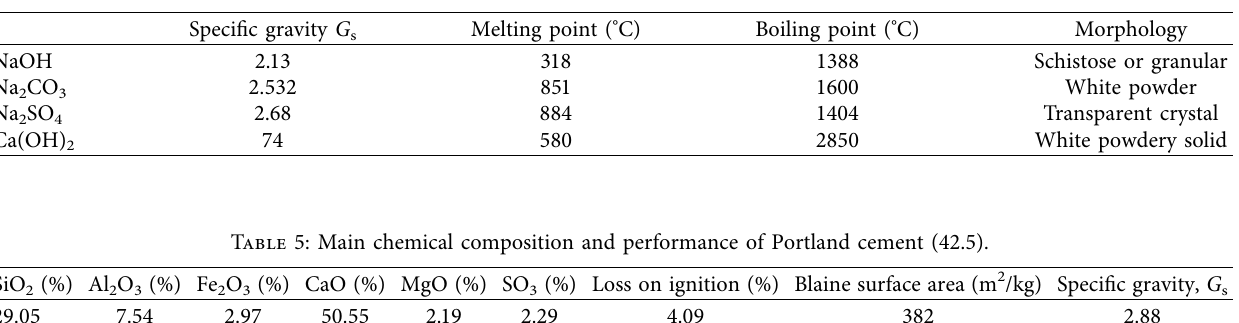
Table 4: Properties of NaOH, Na 2 CO 3 , Na 2 SO 4 , and Ca(OH) 2 alkaline